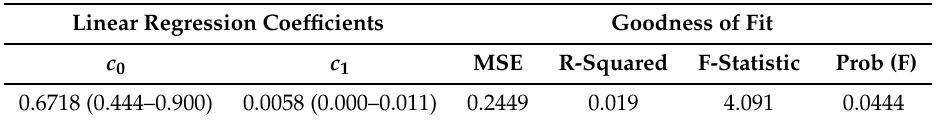
Table 7. Model coefficients (with confidence interval in parenthesis) and goodness of fit metrics for rain vs. power linear model.